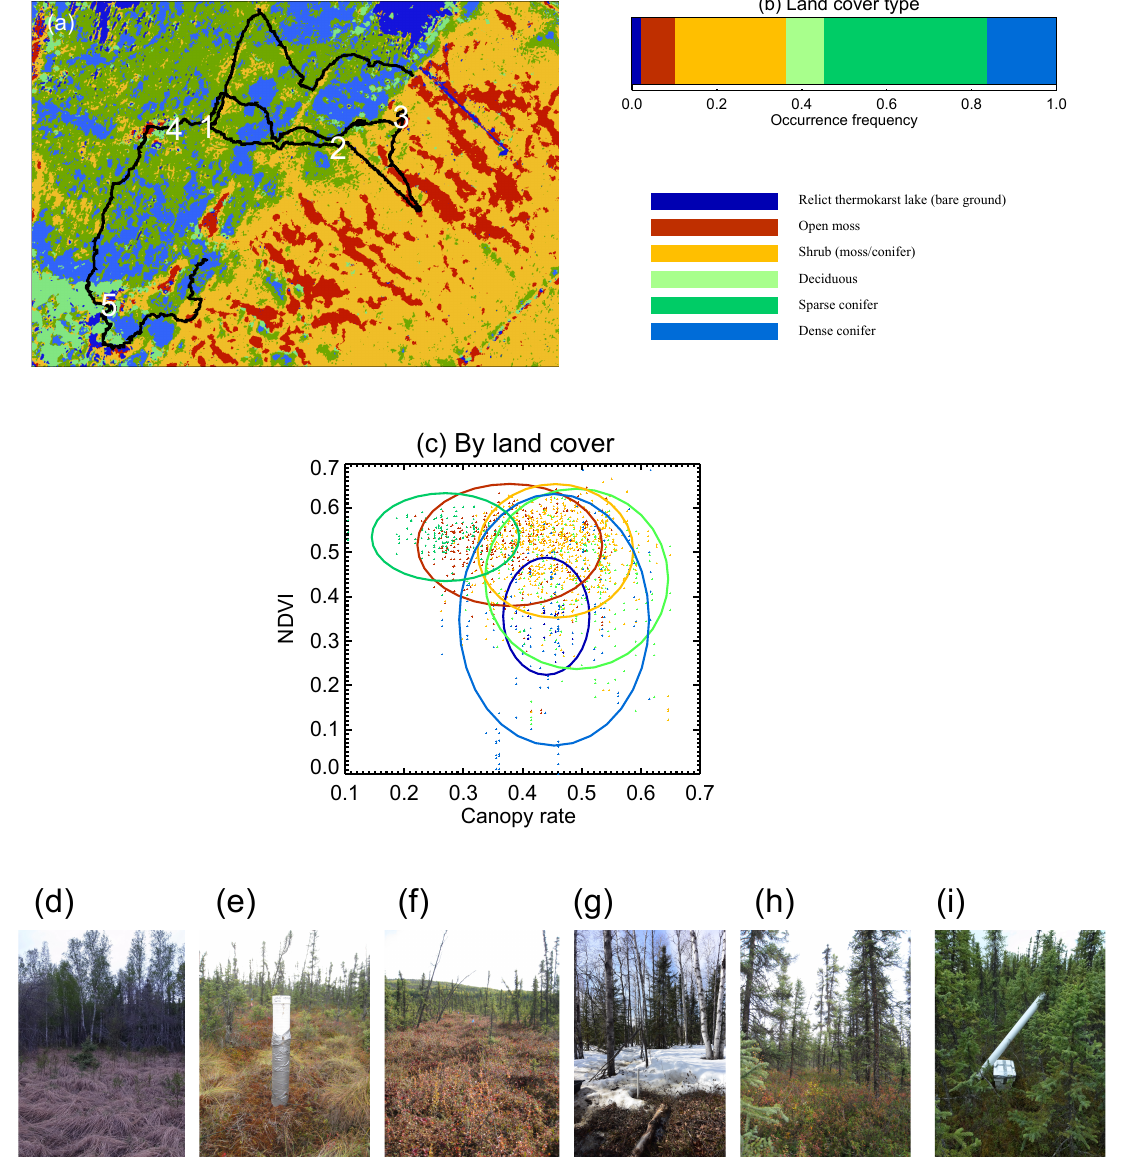
Figure 2. (a) Layout of the fibre-optic cable sensor (black line) installed at the PFRR with stations numbered from 1 to 5 (in white), together with the land cover types designated from satellite images (dark blue: relict thermokarst lake, red: open moss, orange: shrubs, light green: deciduous forest, green: sparse conifer forest, blue: dense conifer forest). (b) Frequency of land cover types along the cable. (c) Scatter plot of surface-measured canopy rate and satellite-derived normalized difference vegetation index (NDVI; GeoEye1 image taken on 25 September 2010). Images show examples of (d) relict thermokarst lake, (e) open moss, (f) shrub, (g) deciduous forest, (h) sparse conifer forest, and (i) dense conifer